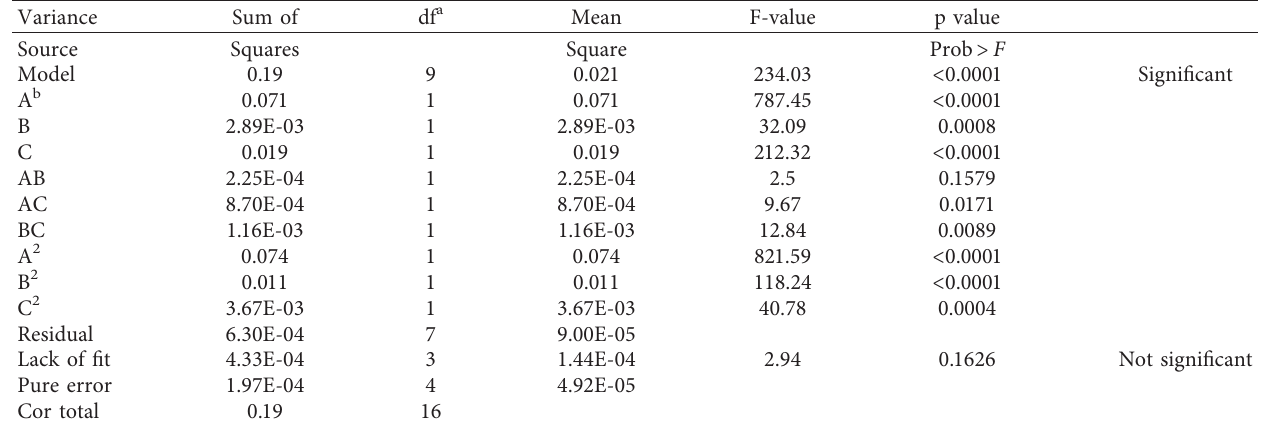
Table 2: Variance analysis of the browning degree experiment.